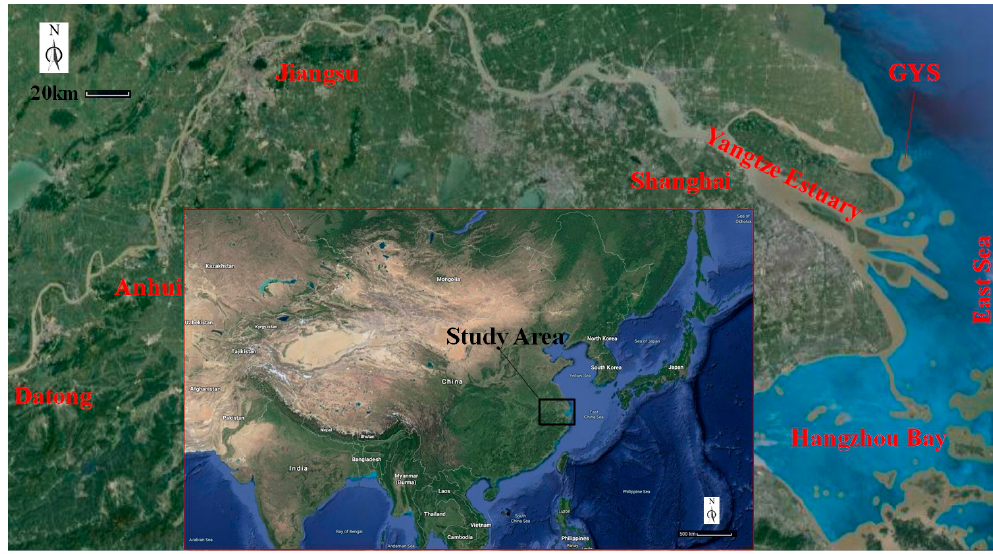
Figure 1. The location of the Yangtze Estuary and the study area (a Google Map that shows the geographical features of the location).